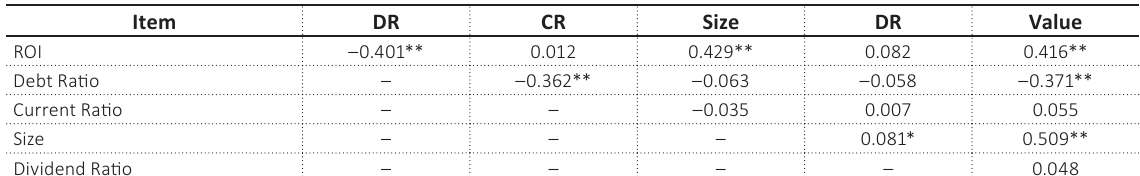
Table 2. Pearson matrix